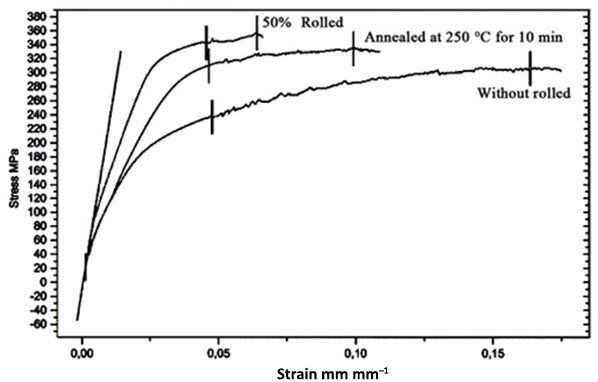
Figure 7. The strain-stress test for the original, crystallized, and 50% cold rolled